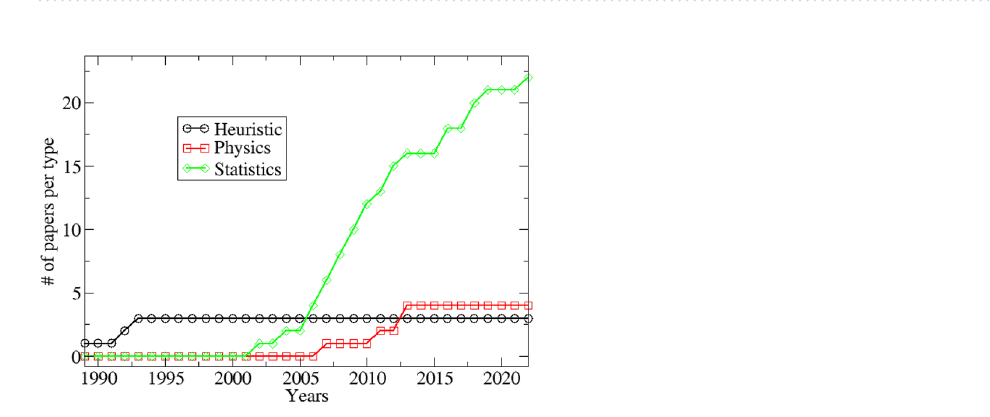
Table 3. Contingency tables for the observed distribution (a) and expected distribution (b) related to the study on the association with the incompleteness of the experimental catalog.